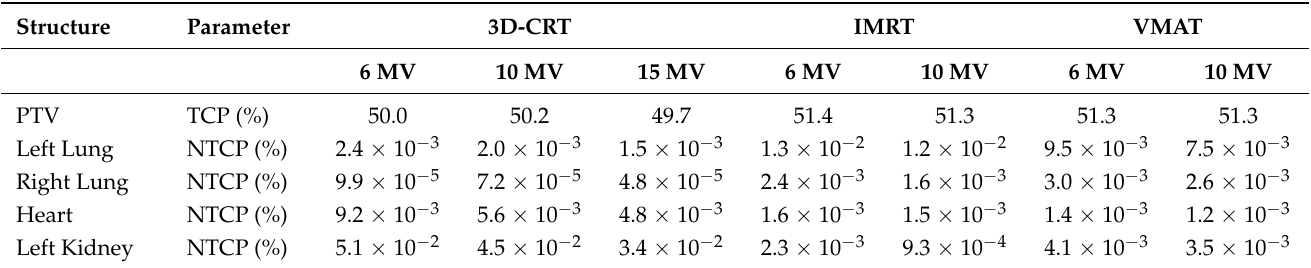
Table 5. TCP and NTCP calculations derived from radiation therapy plans for gastric cancer on a computational phantom representing an adult male